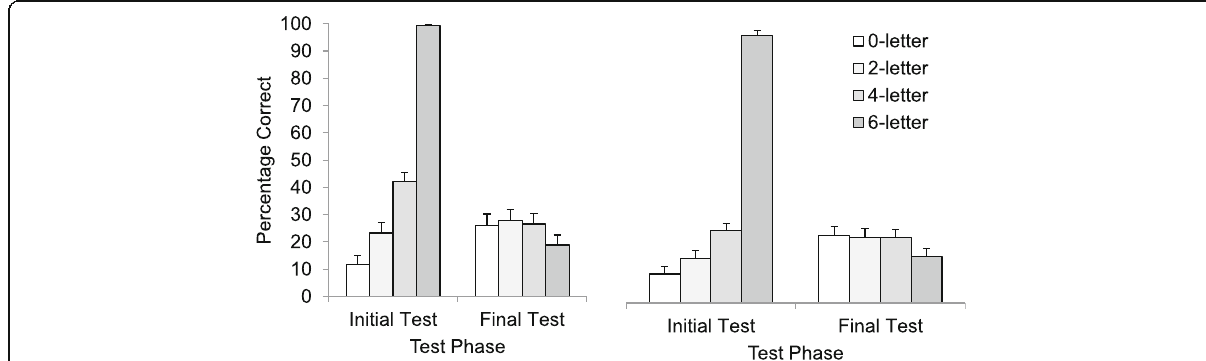
Fig. 3 Initial and final recall performance (reported as a percentage) as a function of trial type in Experiment 3a (left panel) and Experiment 3b (right panel). Error bars report standard error of the